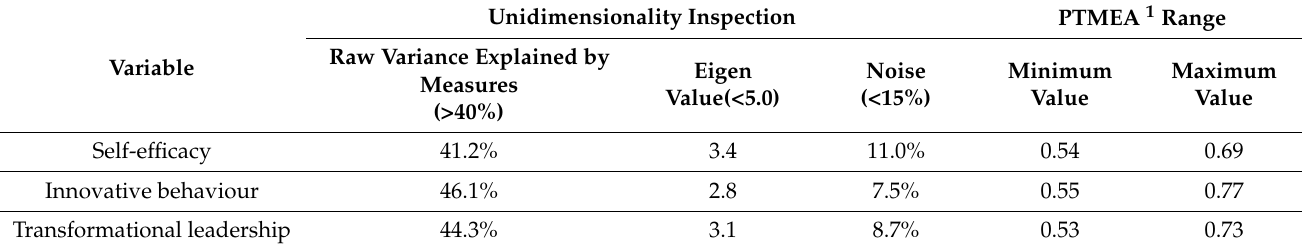
Table 5. Unidimensionality and item polarity of each